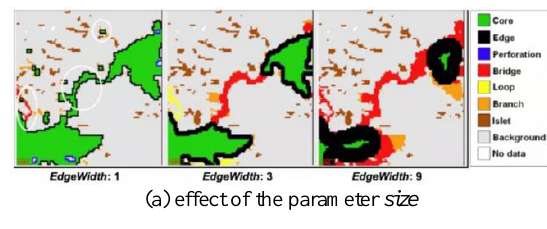
Figure 1 . Morphological segmentation of binary patterns including the detection of connecting pathways leading to 7 classes for the foreground pixels and 3 classes for the background